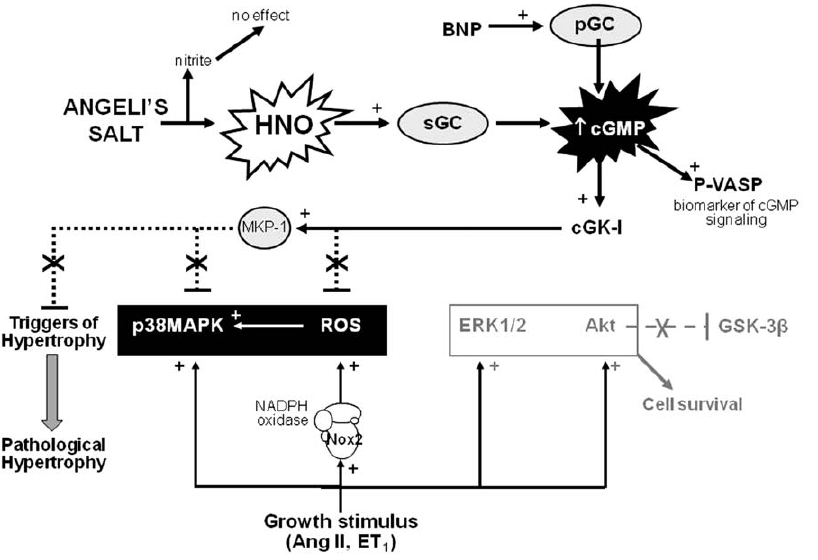
Figure 8. Mechanism of antihypertrophic action of HNO in cardiomyocytes. Angeli’s salt utilizes HNO/sGC/cGMP/cGK-I signaling to suppress key triggers of the hypertrophic response, including expression and activity of NADPH oxidase (Nox2 subunit, a major source of reactive oxygen species, ROS) and activity of p38MAPK (the latter possibly as a result of enhanced activity of MAPK phosphatase-1, MKP-1). Activity of the cell survival kinase Akt (and its downstream target GSK-3 b ) remain intact in the presence of Angeli’s salt. Cardiomyocyte hypertrophic responses across cell size, de novo protein synthesis and upregulated expression of b -myosin heavy chain are all ameliorated by HNO in the face of preserved cardiomyocyte ERK1/2 activation. Both the antihypertrophic and antioxidant actions of HNO are mediated via serial activation of sGC, cGMP production and cGK-I stimulation. Dashed lines indicate sites of inhibition. See text for references.